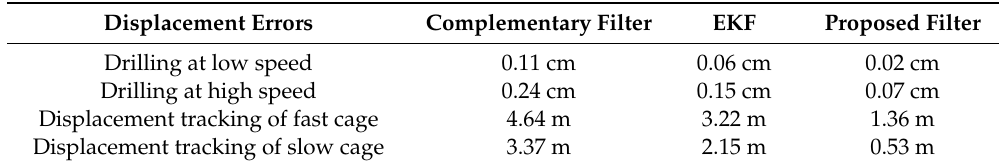
Table 3. RMS errors of di ff erent methods (displacement).